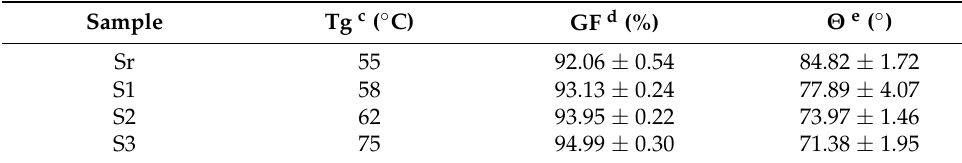
Table 2. DMA, GF, and contact angle results for ELO-LnK composites.